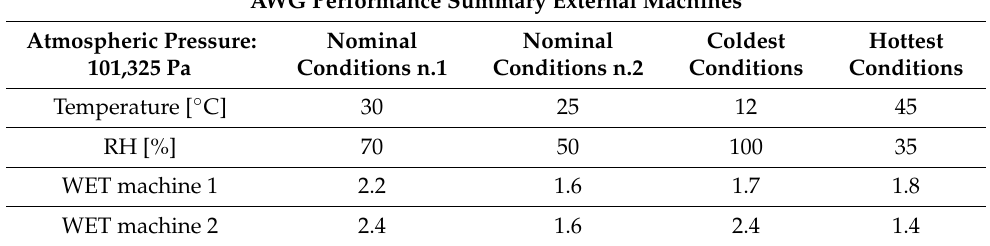
Table 7. Proposed normalised